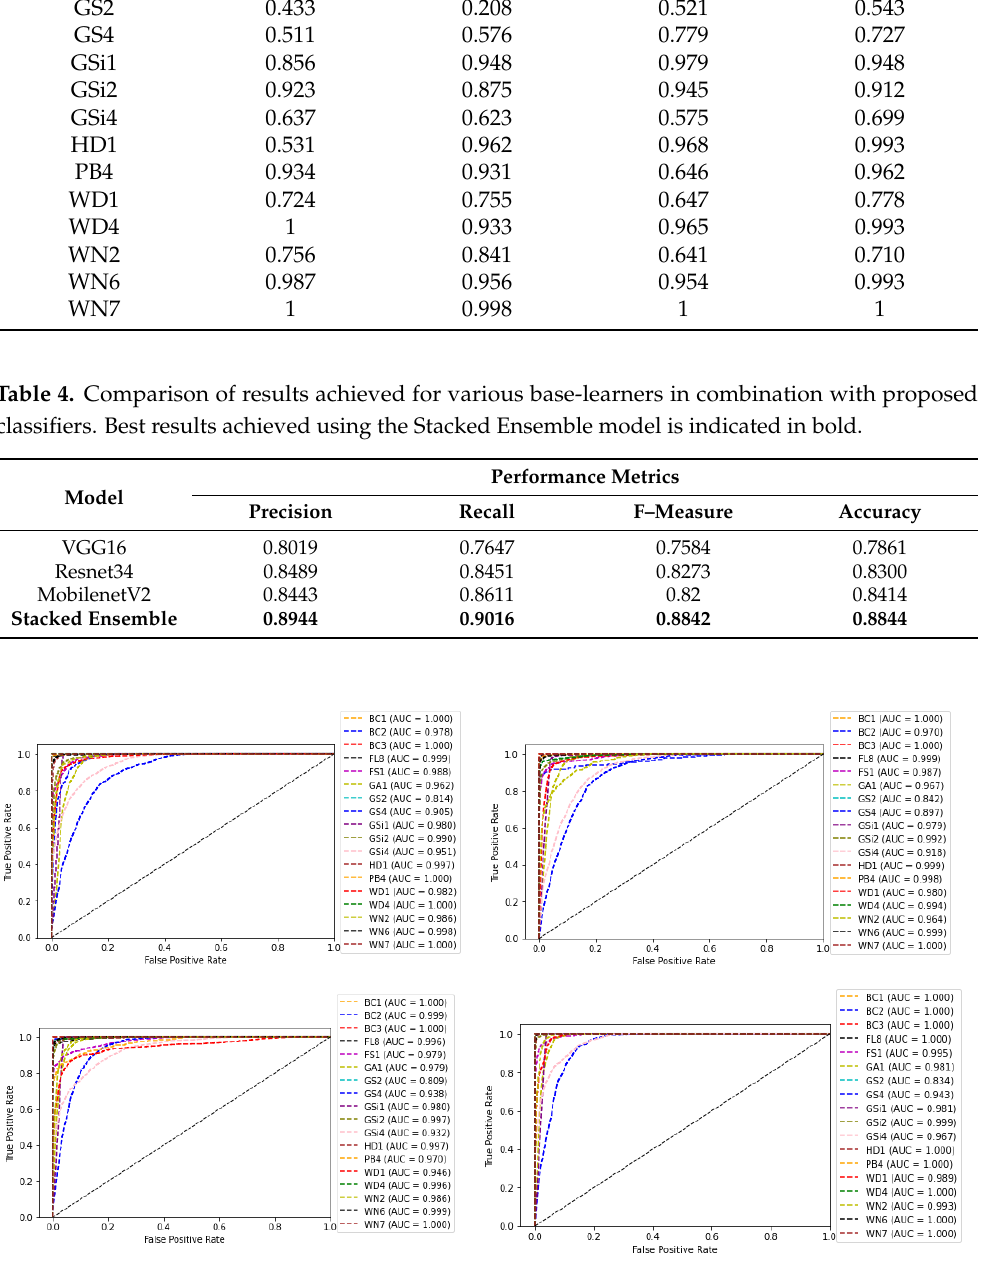
Figure 12. ROC curve and AUC values of base-learners with VGG16, Resnet34, MobilenetV2, and Ensemble models, respectively. Table 5. Comparison of execution time and accuracy for various models. Best results are indicated in bold.